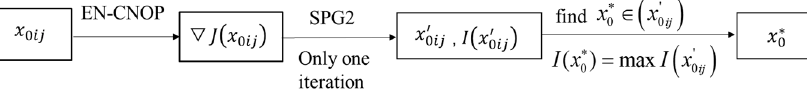
Figure 1. Flow chart of the PAIG ‐ CNOP method to find the optimal initial guess.